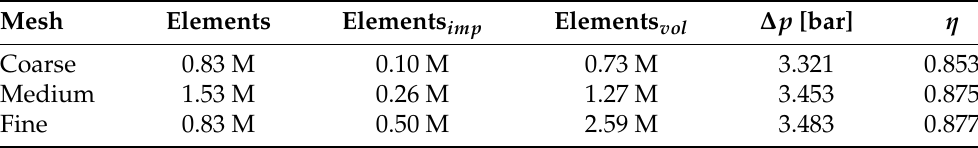
Table 4. Grid convergence study for the baseline geometry. The quantities of interest are the static pressure rise, ∆ p , and the pump hydraulic efficiency, η